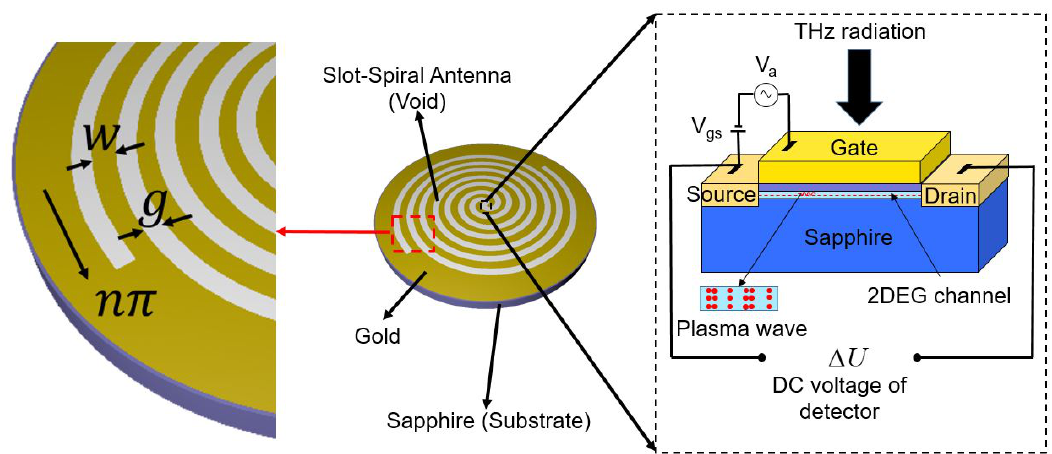
Figure 1. Slot-spiral antenna-coupled field-effect transistor.